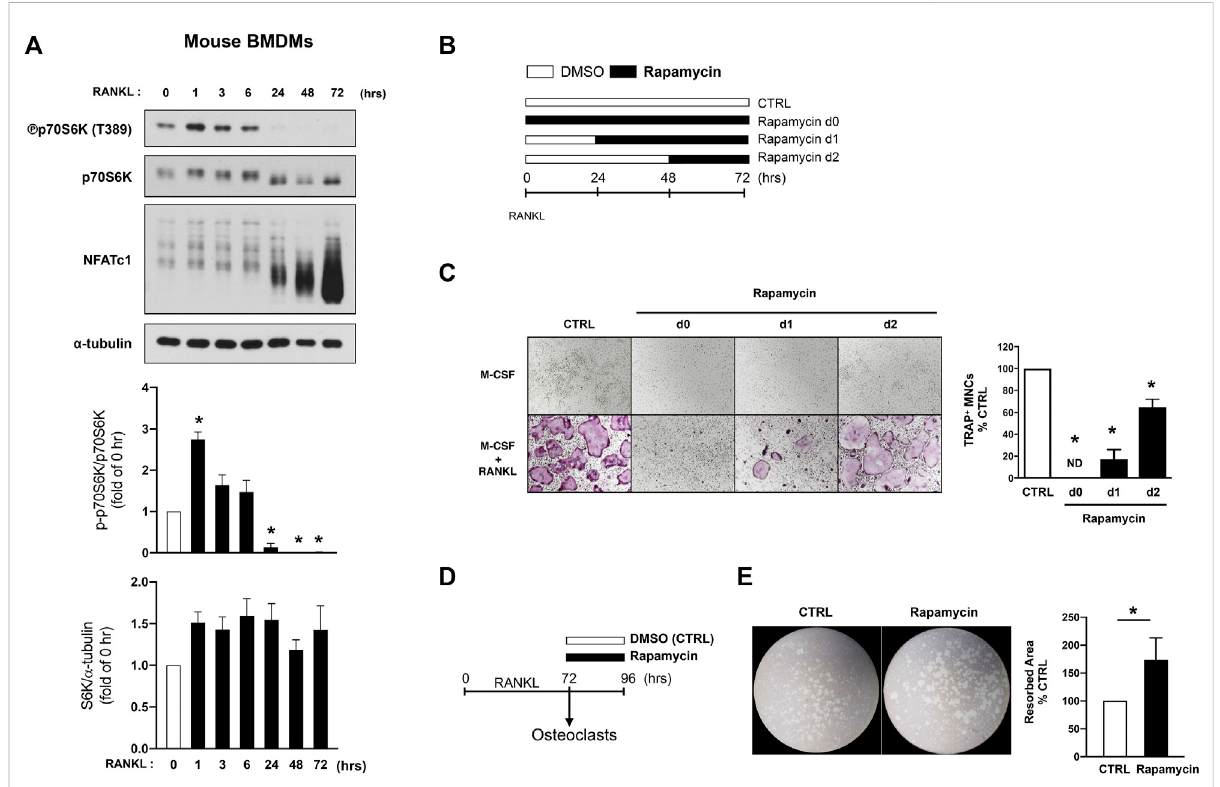
FIGURE 2 mTORC1 signaling has a biphasic effect on mouse osteoclastogenesis. (A) Immunoblot of whole-cell lysates from mouse BMDMs after RANKL stimulationfortheindicatedtimepointswithanti-phosphop70S6K,p70S6K,NFATc1,and α -tubulinantibodies. α -tubulinservedasaloadingcontrol. Graph depicts the quanti fi cation of signal intensity of the phospho p70S6K and total p70S6K immunoblot using densitometry, normalized to the control ( n = 3). (B) A schematic diagram illustrating the experimental design in (C) . (C) Representative images show osteoclast differentiation afterrapamycintreatment(100 nM)atdifferenttimepointsafterRANKLstimulation.GraphdepictsthenumberofTRAP-positivemultinucleatedcells (MNCs) counted in triplicate from three independent experiments. (D) A schematic diagram illustrating the experimental design in (E) . (E) Representativeimagesshowboneresorptionactivityofosteoclastsafterrapamycintreatmentfor24 h.Graphdepictsthepercentageofresorbedpit area per total area from six independent experiments. All data are shown as mean ± SEM. * p < 0.05 by one-way ANOVA with a post hoc Tukey test (A,C) or two-tailed, paired t test (E) . ND, not